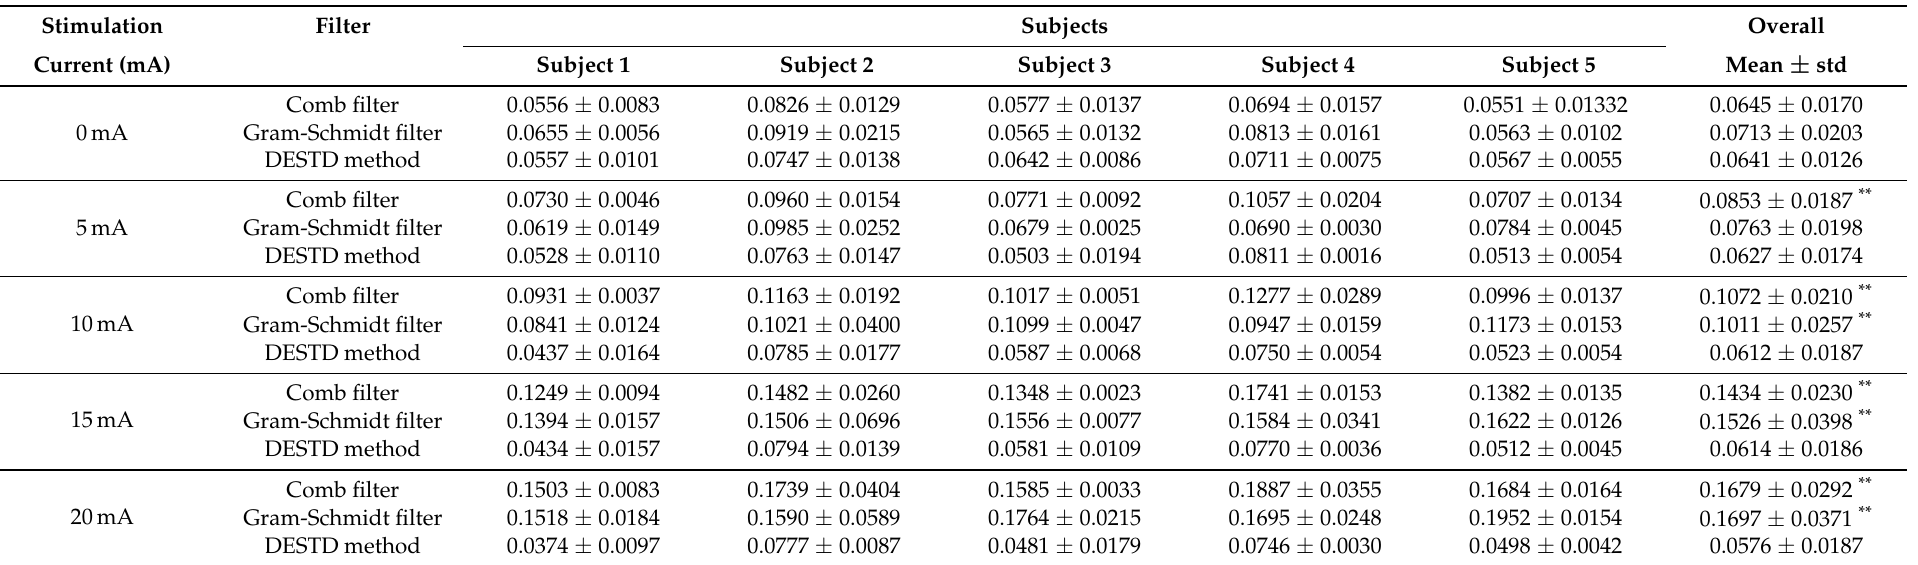
Table 1. Experimental results: NRMSE of the filtered EMG